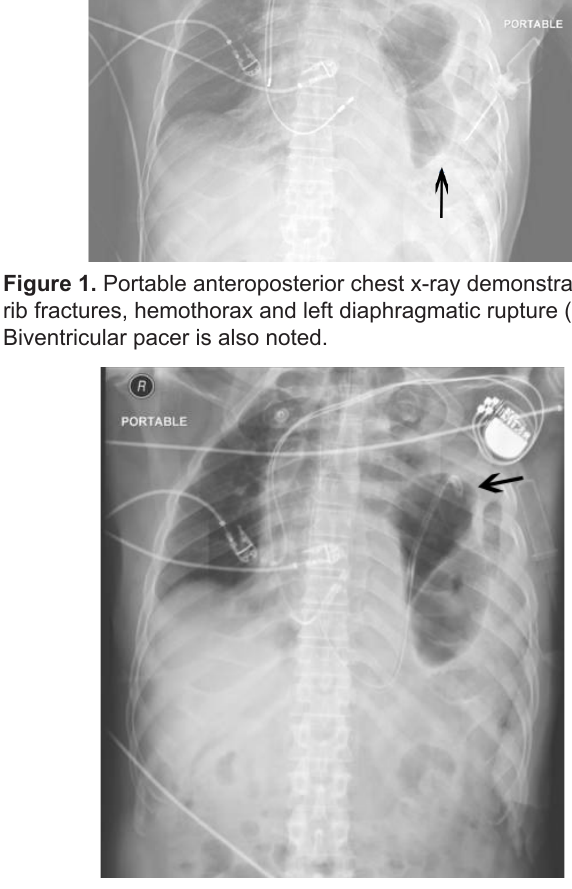
Figure 2. Portable anteroposterior chest x-ray demonstrating successful nasogastric tube insertion with tip extending above ruptured diaphragm into thorax